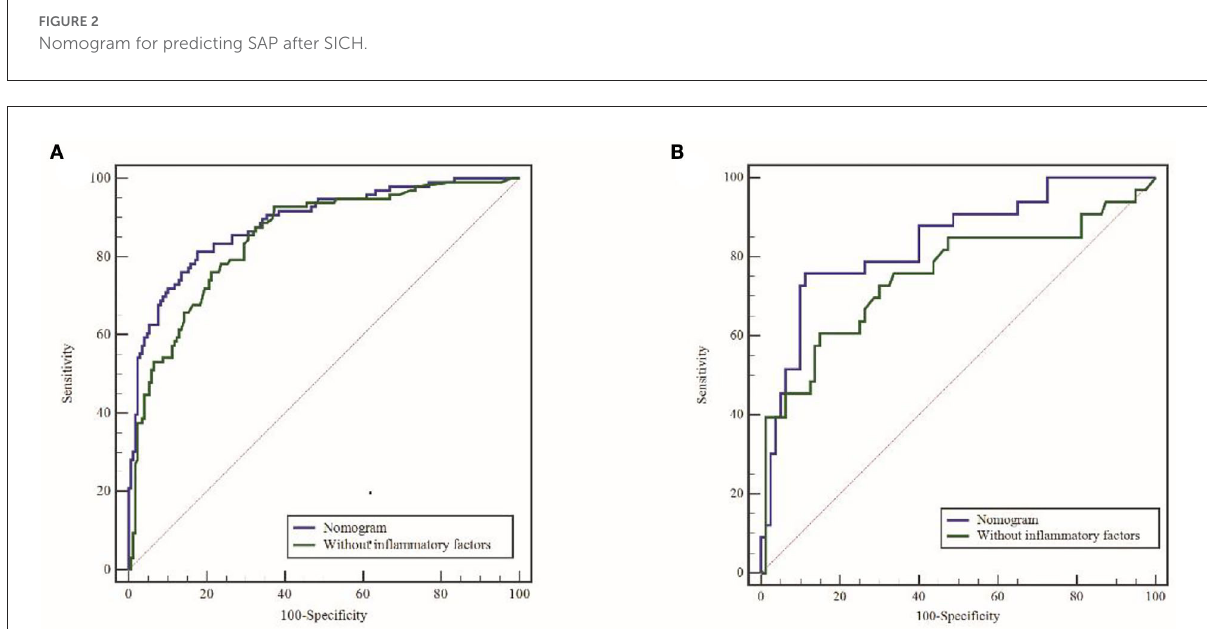
FIGURE3 ROC curves for the raining cohort (A) and validation cohort (B) . ROC, receiver operating characteristic; AUC, area under the